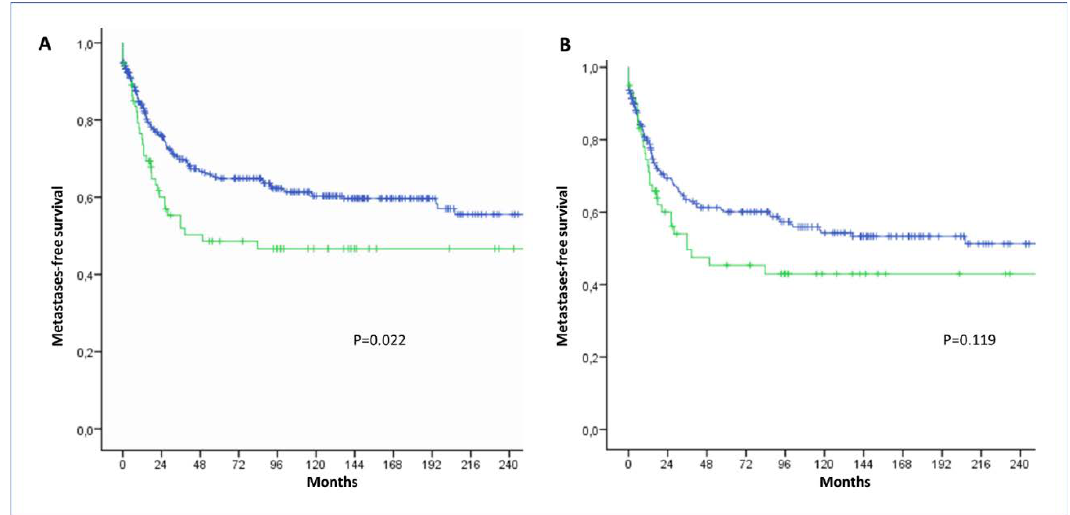
Figure 2. Kaplan-Meier curves of metastases-free survival according LRRC15 expression. ( A ) Kaplan–Meier curves of metastases-free survival according to LRRC15 expression score in a cohort of 425 patients with soft-tissue sarcoma (green line: LRRC15 H score > 160, blue line: LRRC15 H score ≤ 160). ( B ) Kaplan–Meier curves of metastases-free survival according to LRRC15 expression (green line: LRRC15 H score > 160, blue line: LRRC15 H score ≤ 160 ) in patients with grade 3 STS.